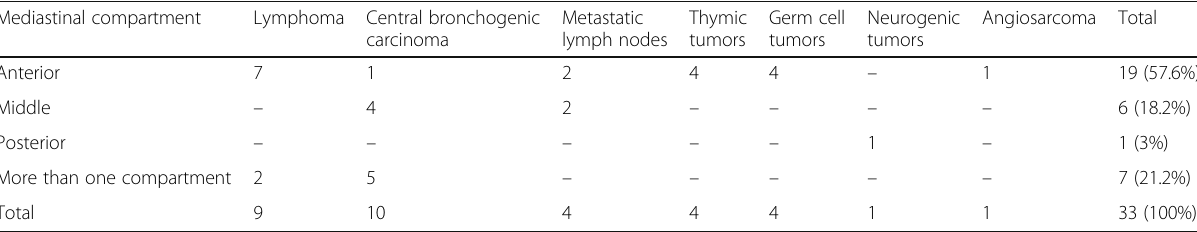
Table 4 Lesions allocated to mediastinal